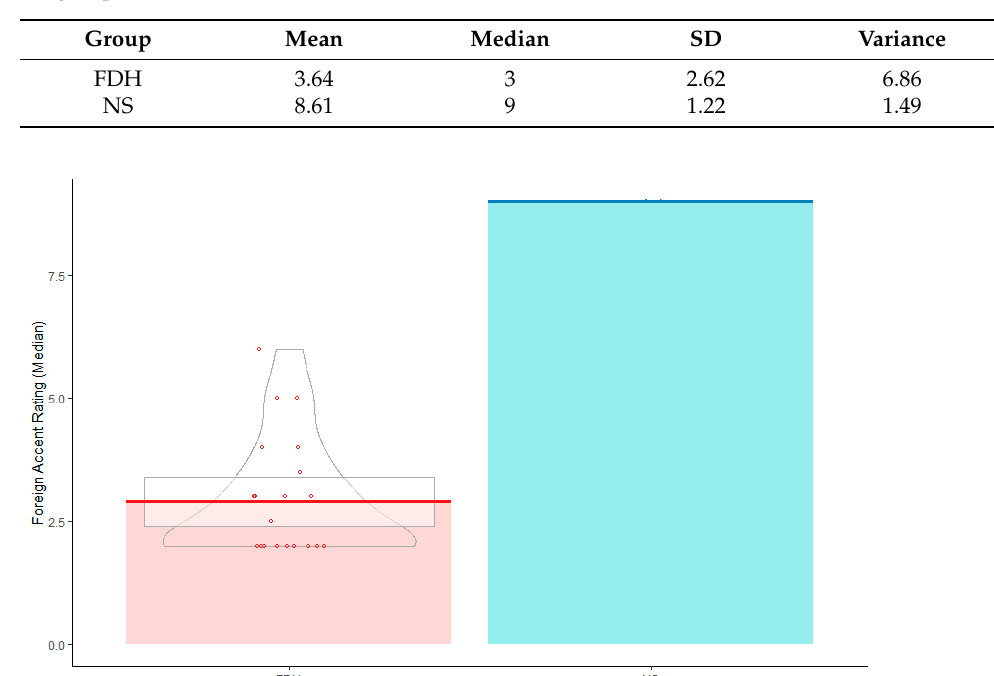
Figure 12. Median and distribution of foreign accent rating scores given to NS and the FDH groups.